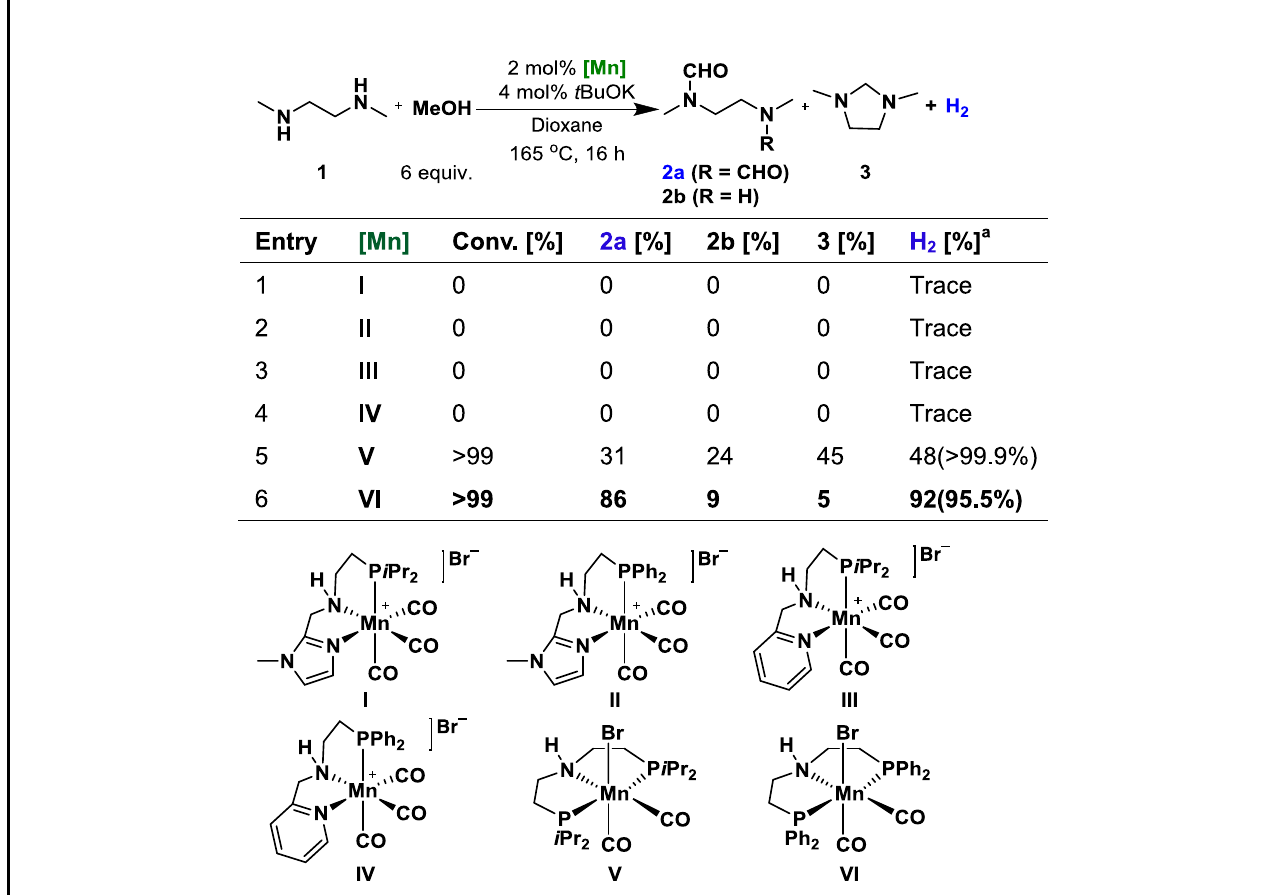
Table 1 Mn-catalyzed dehydrogenative condensation of 1 and CH 3 OH.